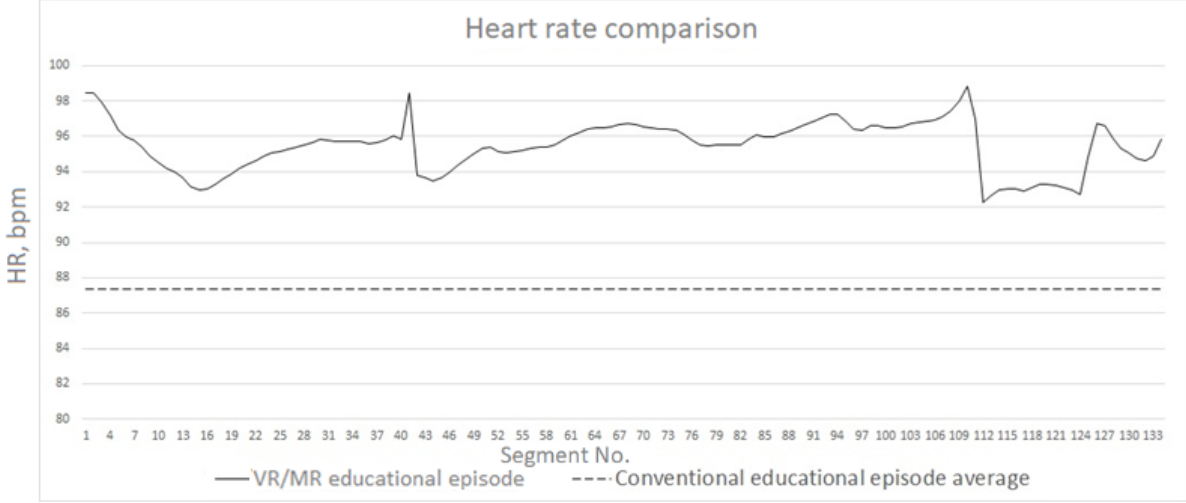
Figure 3. Representative heart rate segment plot for the VR/MR educational episode. Dashed line denotes the baseline established in the first experimental session. HR: heart rate; MR: mixed reality; VR: virtual reality.